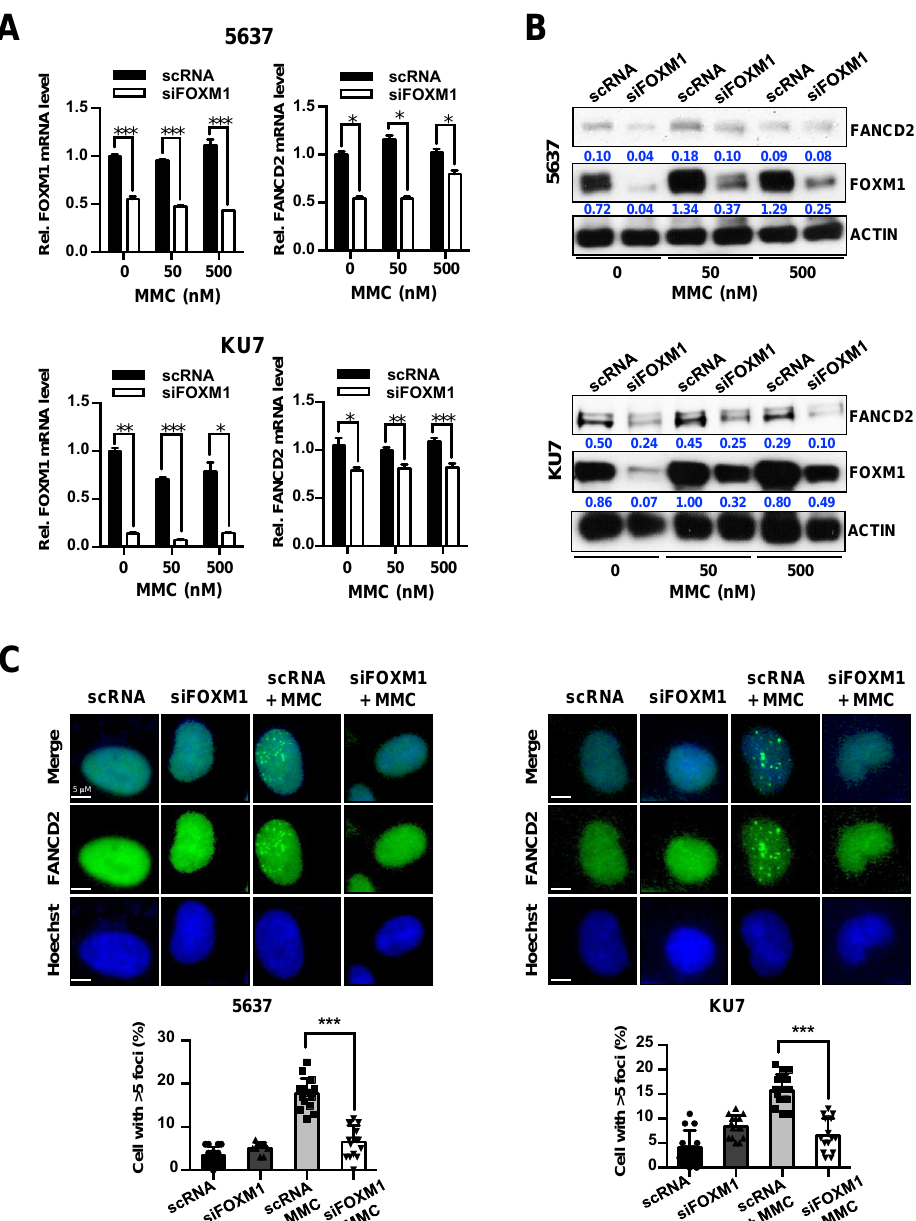
Figure 4. Control of FANCD2 expression and repair activity of FANCD2 following inhibition of FOXM1 and MMC treatment. siRNA (scRNA or siFOXM1)-transfected 5637 and KU7 cells were exposed to MMC for 24 hours. ( A ) FOXM1 and FANCD2 mRNA expression was measured by qRT-PCR. ( B ) FOXM1 and FANCD2 protein levels were analyzed by Western blot. ( C ) Nuclear foci formation of FANCD2 measured by immunofluorescence. Hoechst 33342 stained nuclear region. (*, p < 0.05; **, p < 0.01; and ***, p <